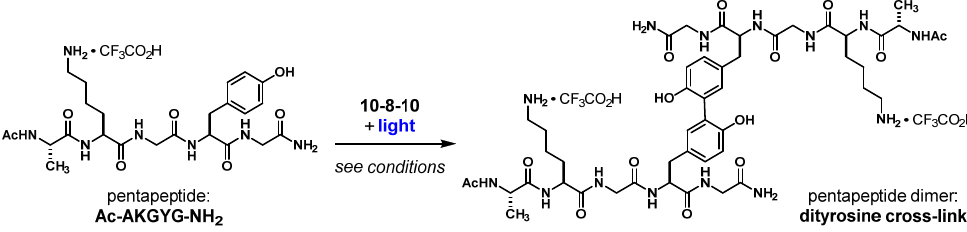
Figure 3. ( A – C ) Proposed 10-8-10 Dimer promoted reactions to generate oxidized amino acids [AA]* intermediates and subsequent crosslinks (AA—AA).